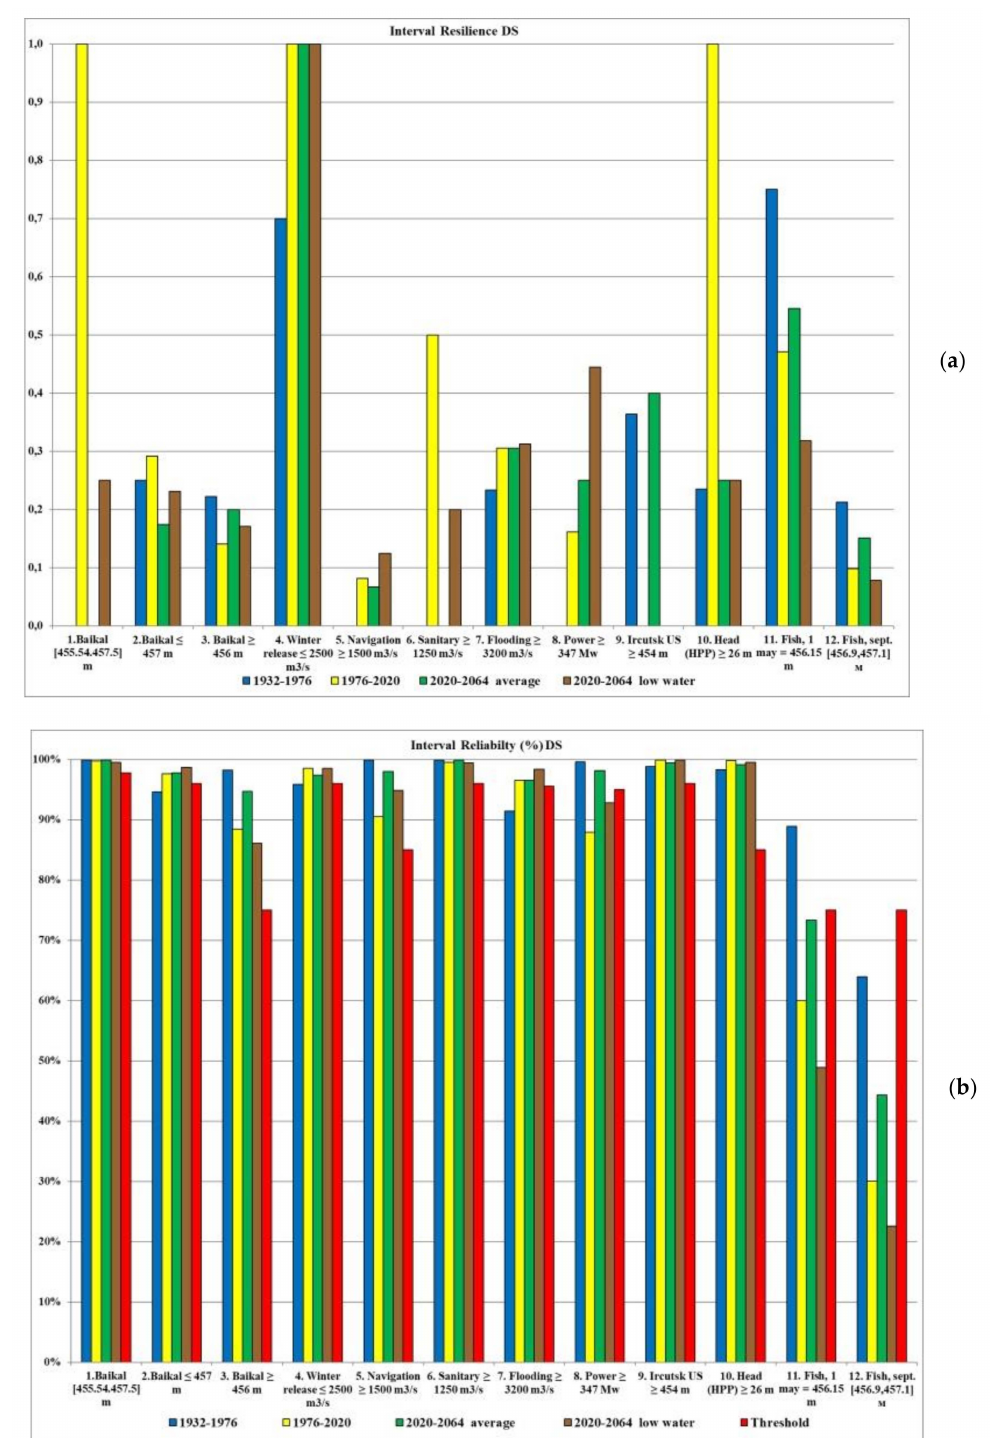
Figure 12. The resilience ( a ) normalized vulnerability ( b ) for different time series